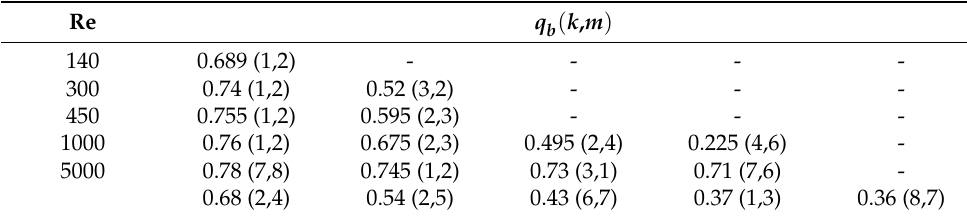
Table 5. Branching points of modes.